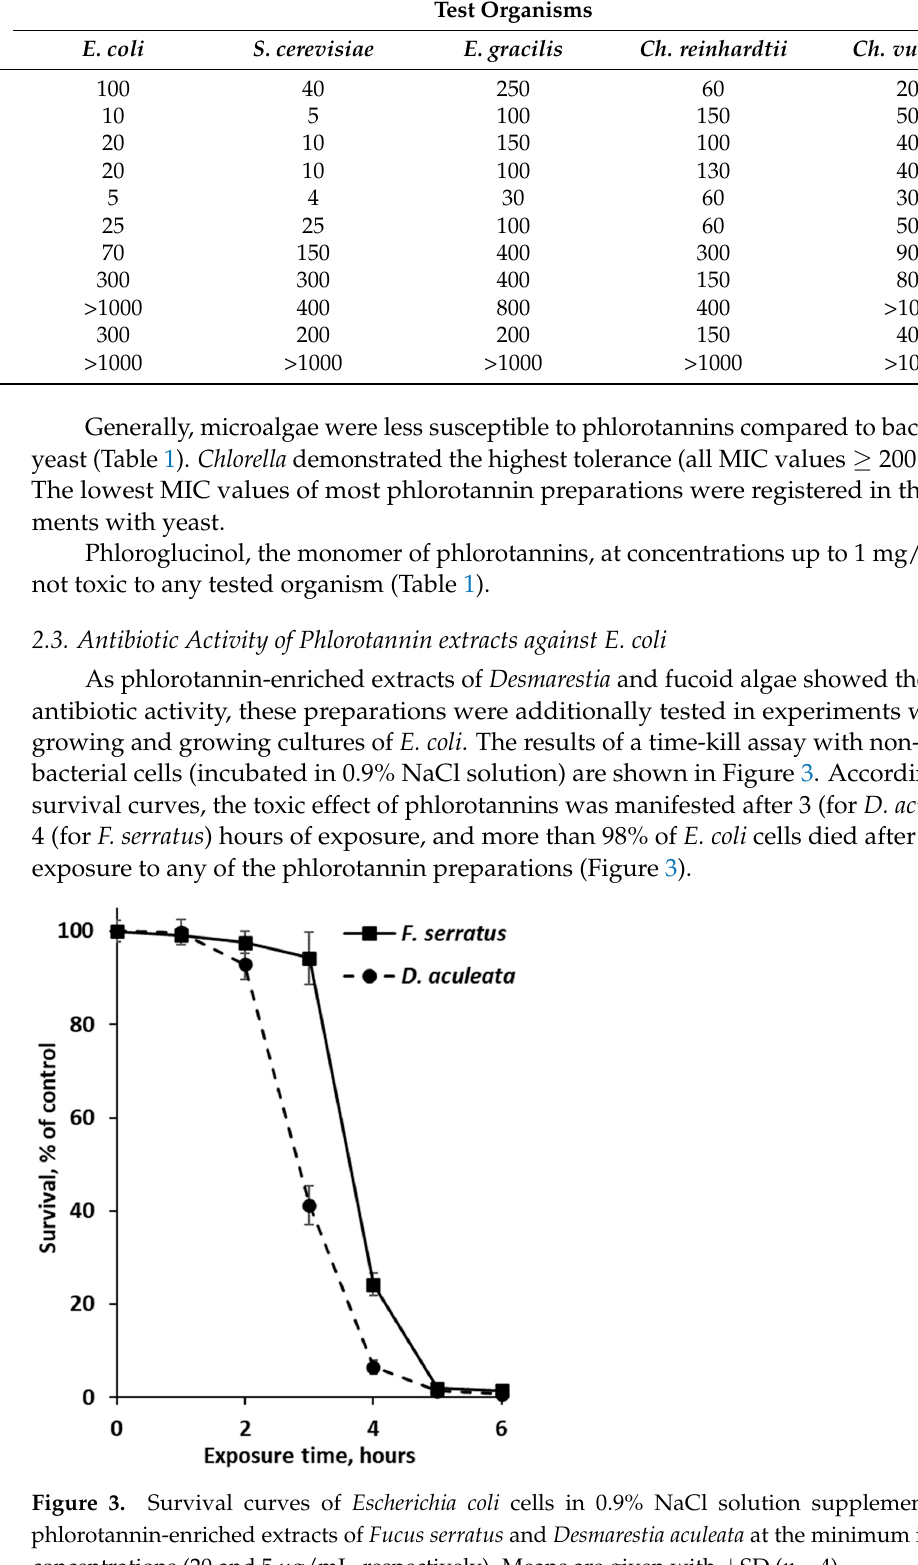
Figure 4. Growth curves of Escherichia coli cultures in VB medium (control) or VB medium supple- mented with phlorotannin-enriched extracts (PT) of Fucus serratus ( a ) and Desmarestia aculeata ( b ). Means are given with ±SD ( n = 4).